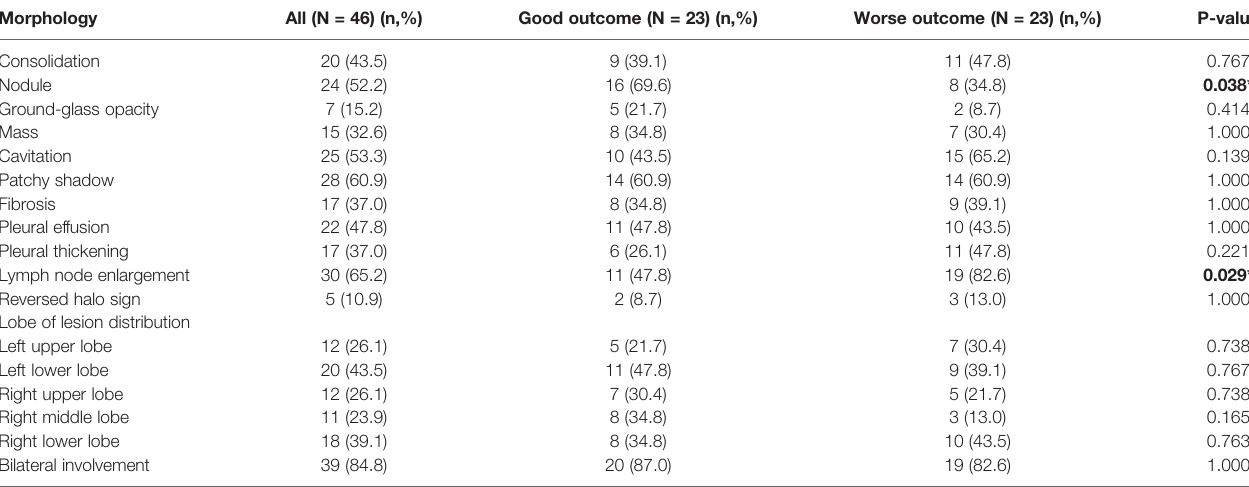
TABLE 3 | Chest CT fi ndings of proven patients with pulmonary mucormycosis . Morphology All (N = 46) (n,%) Good outcome (N = 23) (n,%) Worse outcome (N = 23)